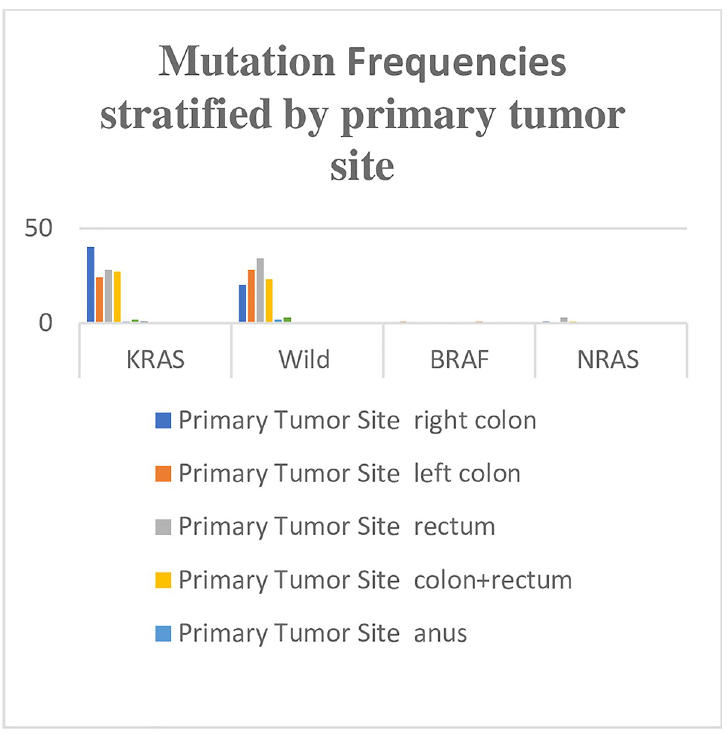
Fig 2. Distribution of mutation frequency of KRAS , NRAS and BRAF genes among 248 CRC patients stratified by primary tumor site.